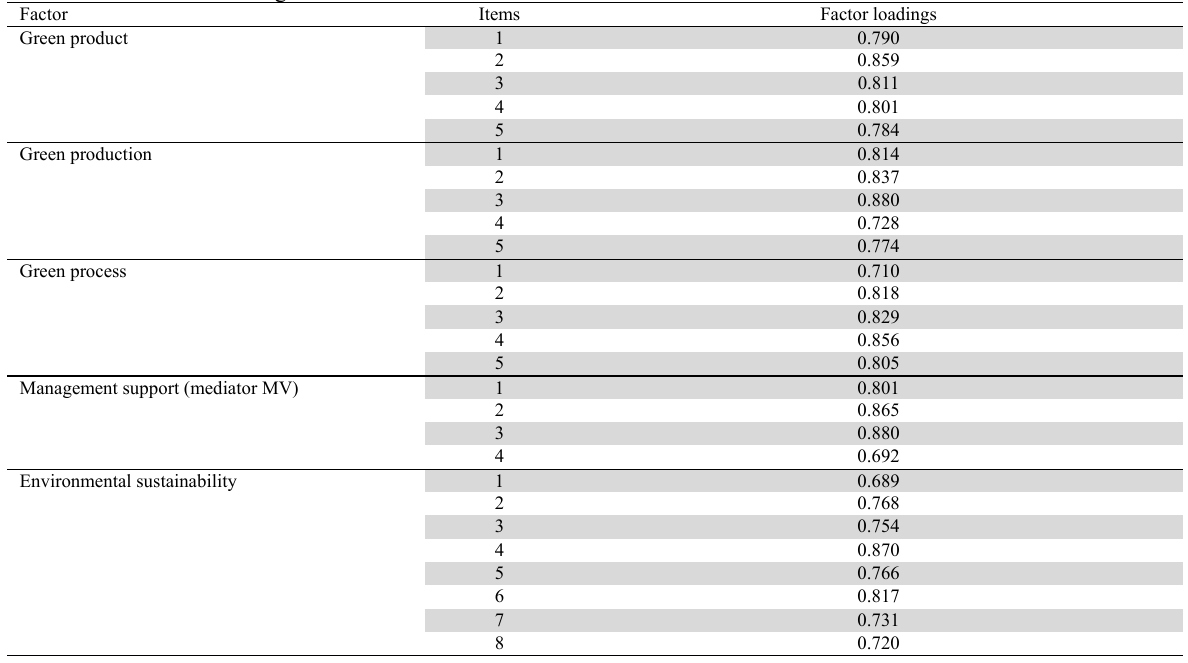
The results of Factor Loading .